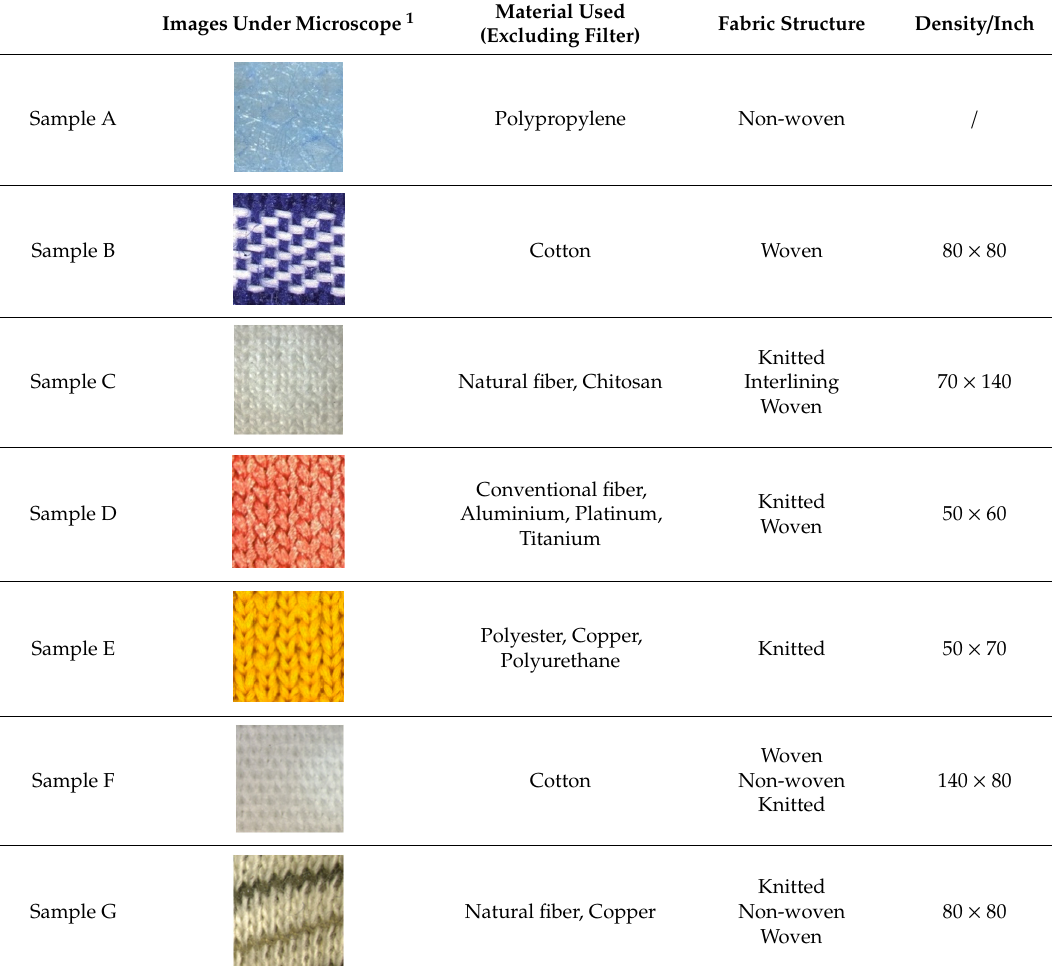
Table 1. Specifications of di ff erent masks.